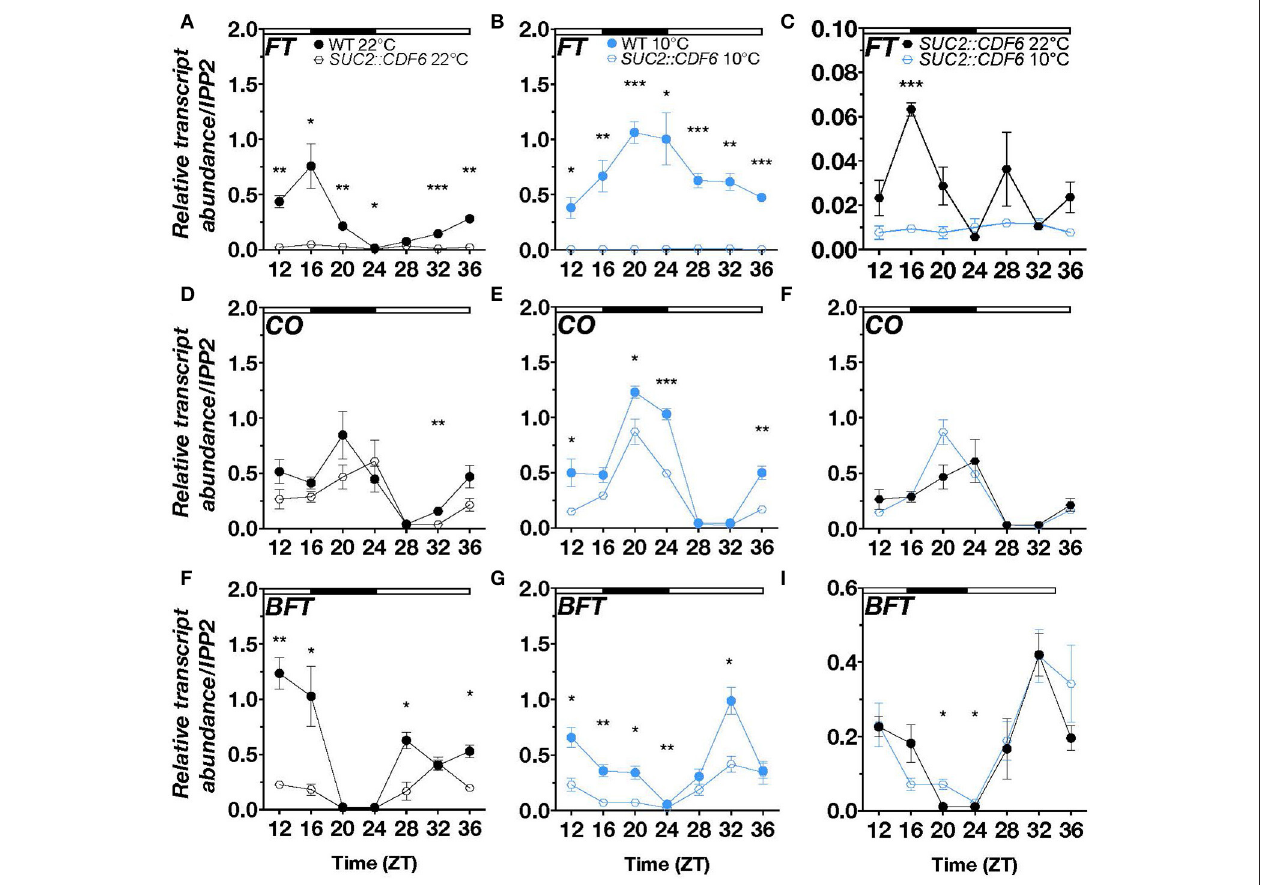
FIGURE 4 | CDF6 alters FT , CO, and BFT expression during cold stress. qRT-PCR of (A–C) FT , (D–F) CO, and (G–I) BFT relative transcript abundance in WT and SUC2::CDF6 seedlings. Plants were grown in long-day conditions at 22 ◦ C for 8 days followed by 2 days continuously at 22 ◦ C or 10 ◦ C. Seedlings were sampled every 4h starting at 12h after dawn. (C) FT (F) CO, and (I) BFT transcript abundance in SUC2::CDF6 at 10 ◦ C and 22 ◦ C from the data shown in A and B, D and E, and G and H, respectively. White and black bars indicate the day and night periods, respectively. mRNA levels are normalized to IPP2 (mean values ± SE, n = 3; *** P ≤ 0.001, ** P ≤ 0.01, * P ≤ 0.05; unpaired student’s t